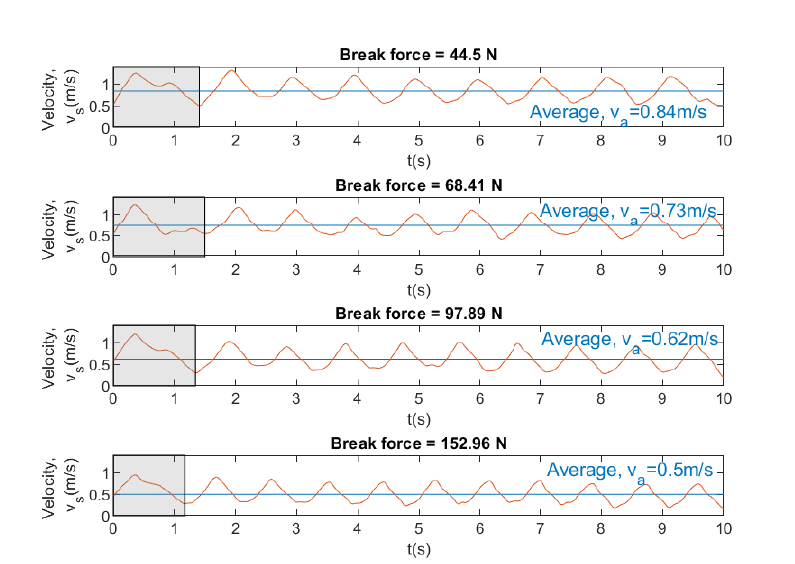
Figure 17. Instantaneous and average velocity for swimming stroke breaststroke at different brake forces.